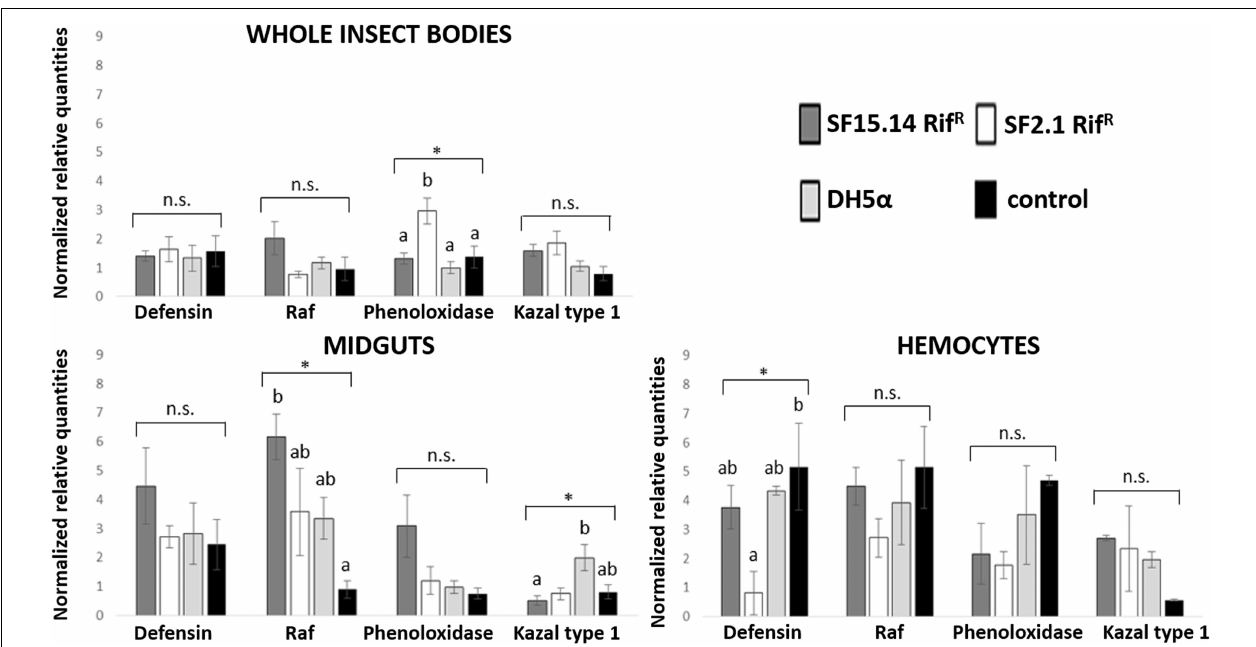
FIGURE 3 | Expression profiles of immune-related genes in E. variegatus samples of the EFDi group. Gene expression was measured in the whole bodies, midguts, and cultured hemocytes of adults treated with Asaia SF15.14Rif R , Asaia SF2.1Rif R , and E. coli DH5 α pKan(DsRed), along with the control. Normalized relative quantities, calculated by 2 - (cid:49)(cid:49) Ct method, are indicated for defensin , Raf , phenoloxidase , and kazal type 1 serine protease inhibitor genes. Bars indicate standard errors. Asterisks show significant differences according to ANOVA ( P < 0.05); different letters indicate significantly different values according to Tukey’s test (a < b).